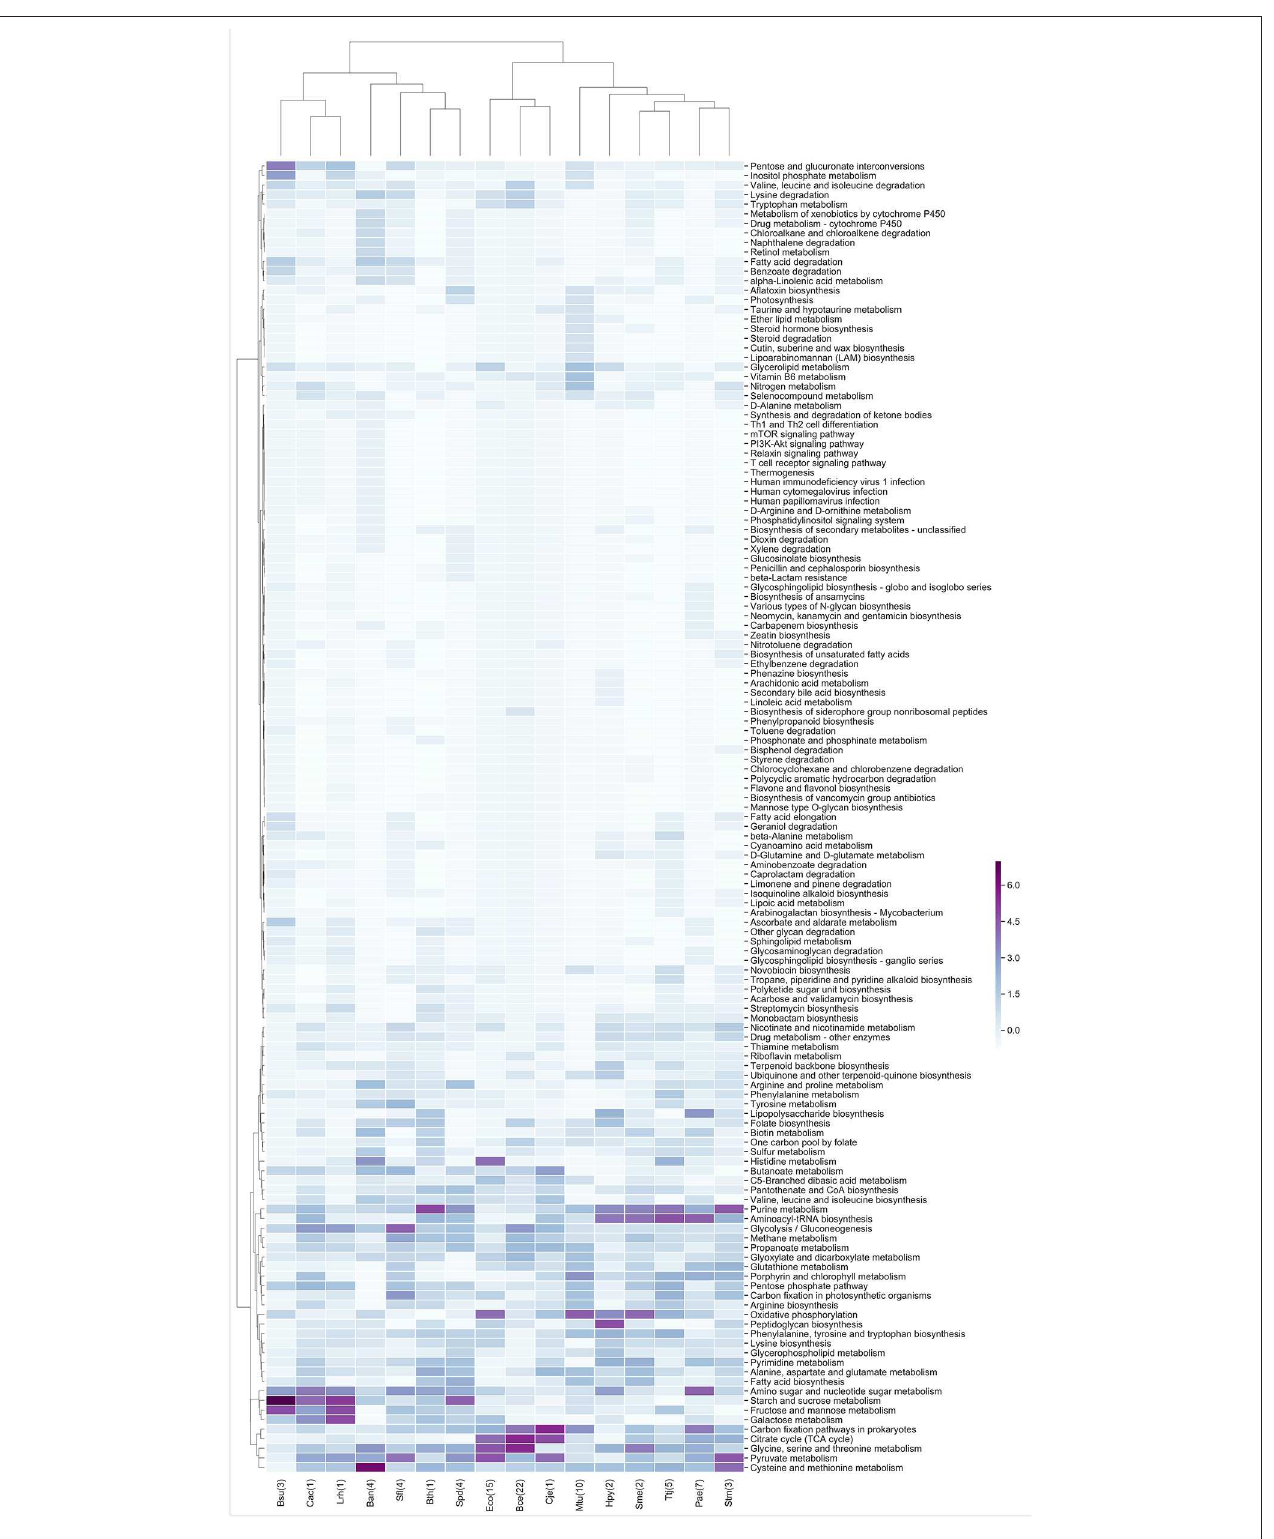
FIGURE 4 | Metabolic maps more frequent in the enriched modules. Z -score hierarchical clustering based on Euclidean distance measure and Ward’s method for linkage analysis. Each row represents a metabolic map (KEGG), and each column represents the most enriched module, with E.C. numbers for each species.